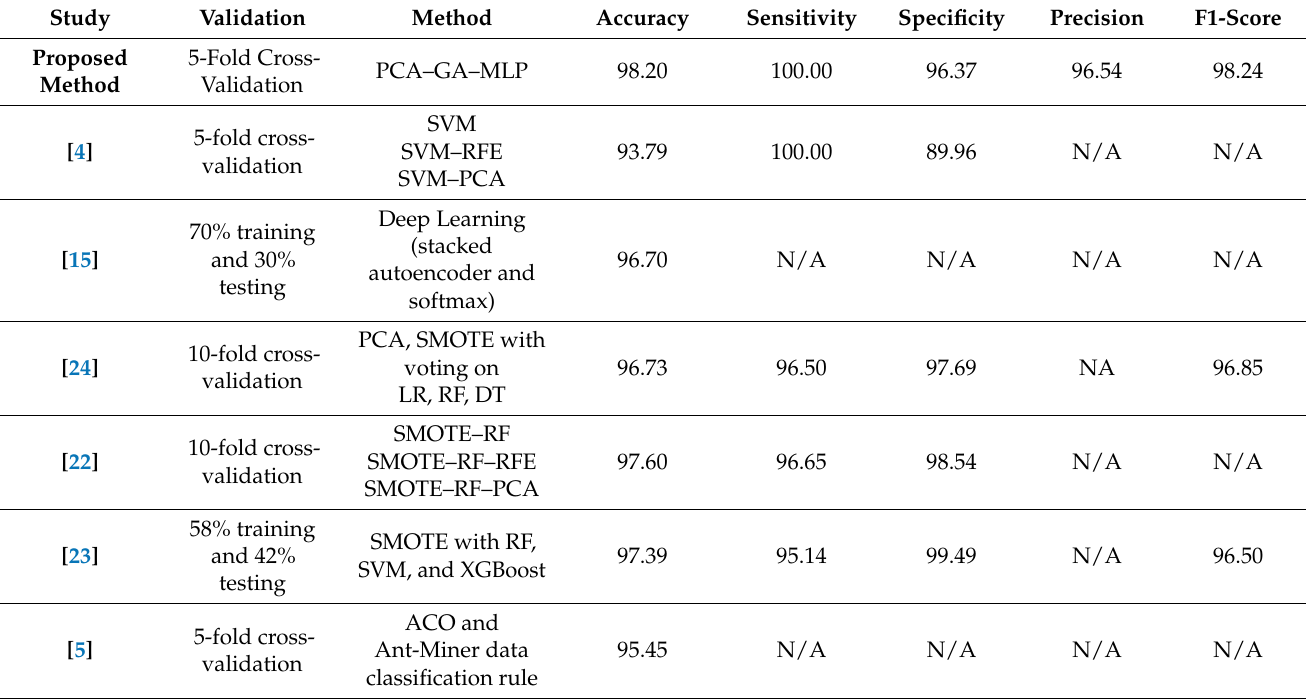
Table 6. Comparison of the proposed method with the best results in the literature in diagnosing